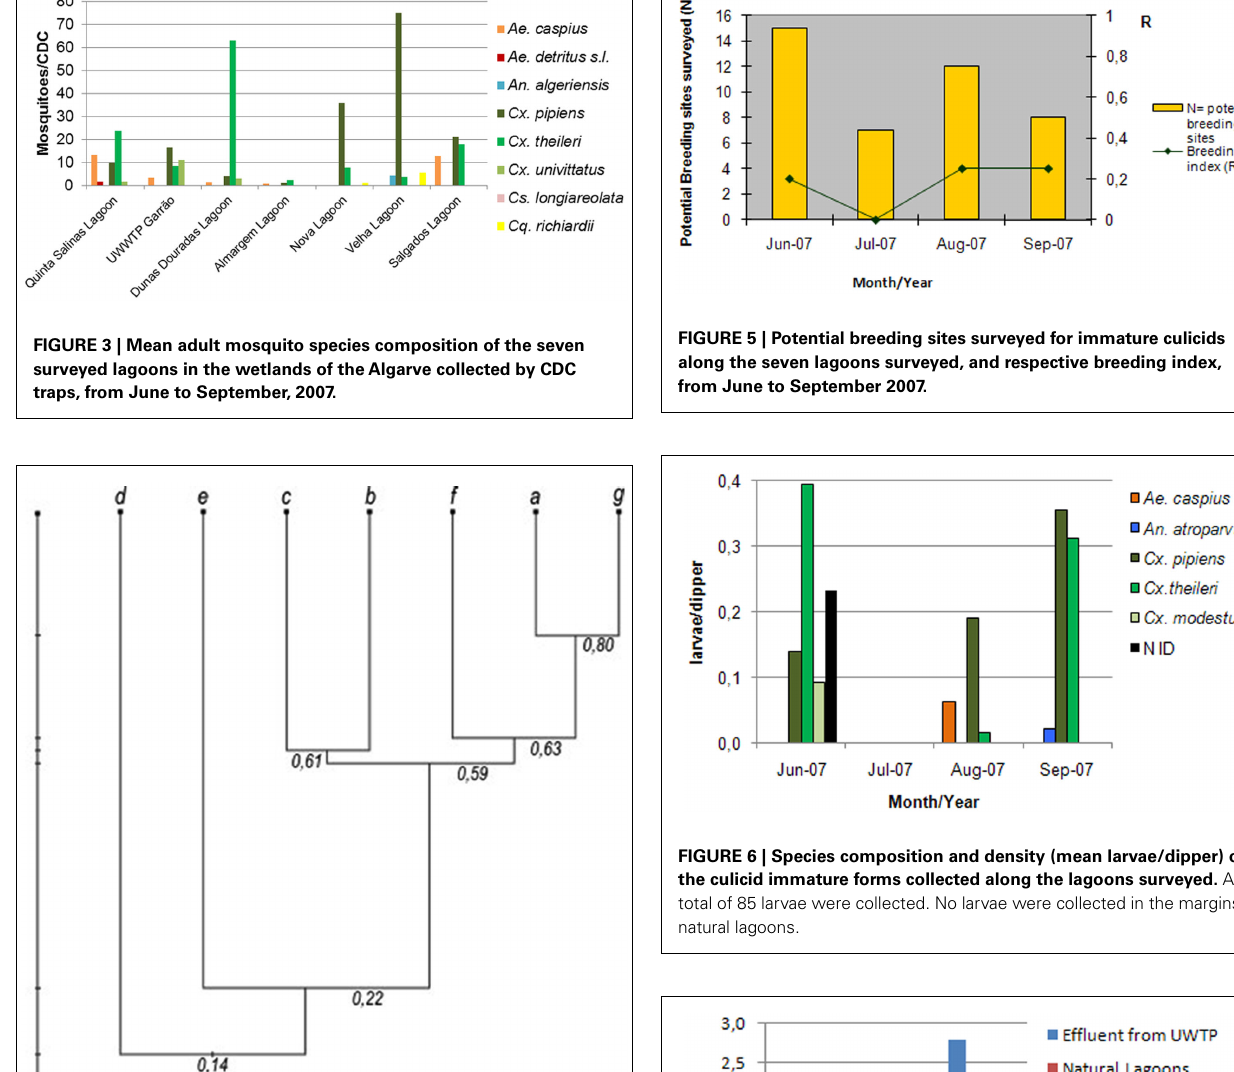
their mean values,during the observation period,for each of these lagoons ( Table 1